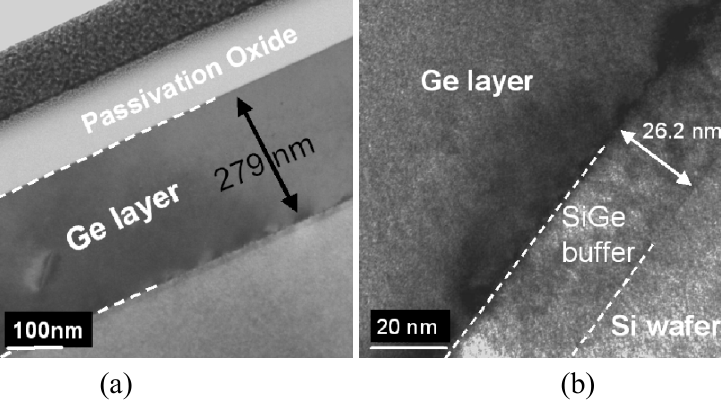
Ge /Ge. From 0.75 0.25